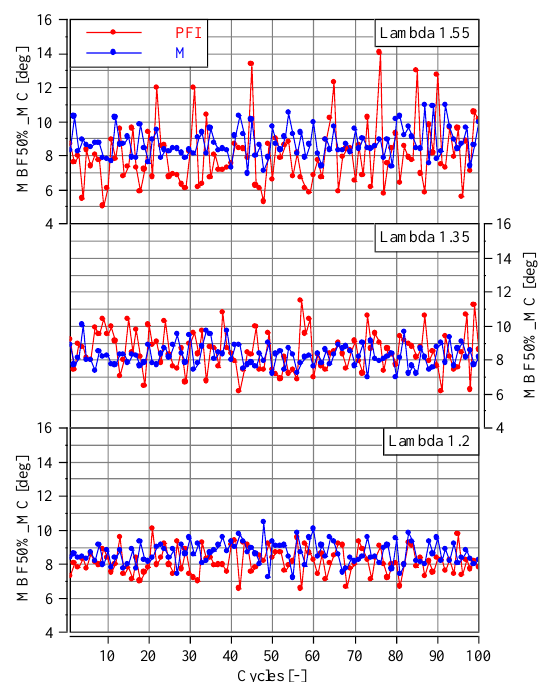
Fig. 12. Cycle by cycle variability of MBF50% for three different lambda